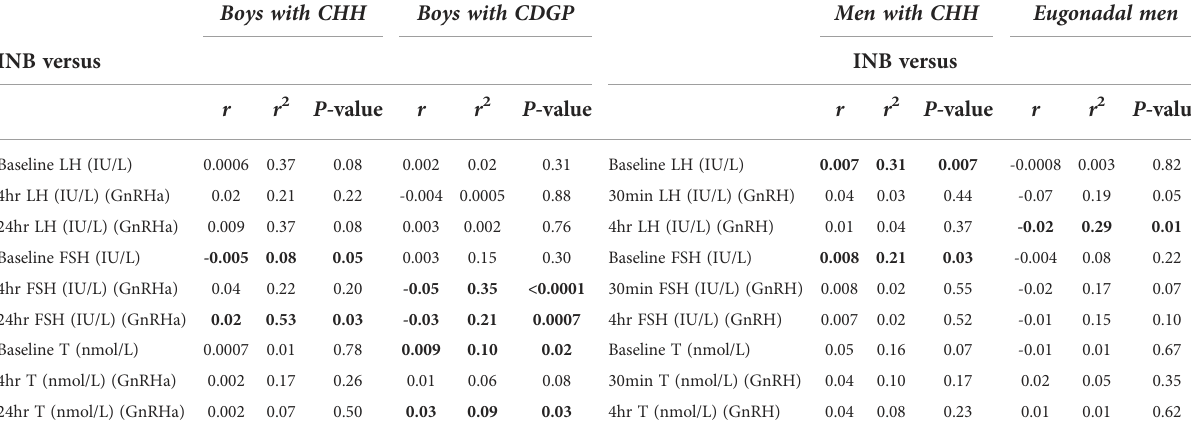
TABLE 2 Linear regression analysis of INB versus baseline and stimulated LH, FSH, testosterone in the delayed puberty and adult cohorts. Boys with CHH Boys with CDGP Men with CHH Eugonadal men INB versus INB versus